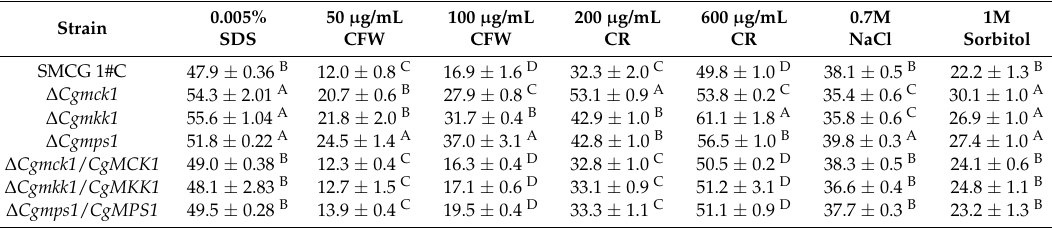
Table 1. Inhibition rate of mycelia growth of the targeted gene mutants exposed to the cell wall-perturbing agents and osmotic stresses (%).